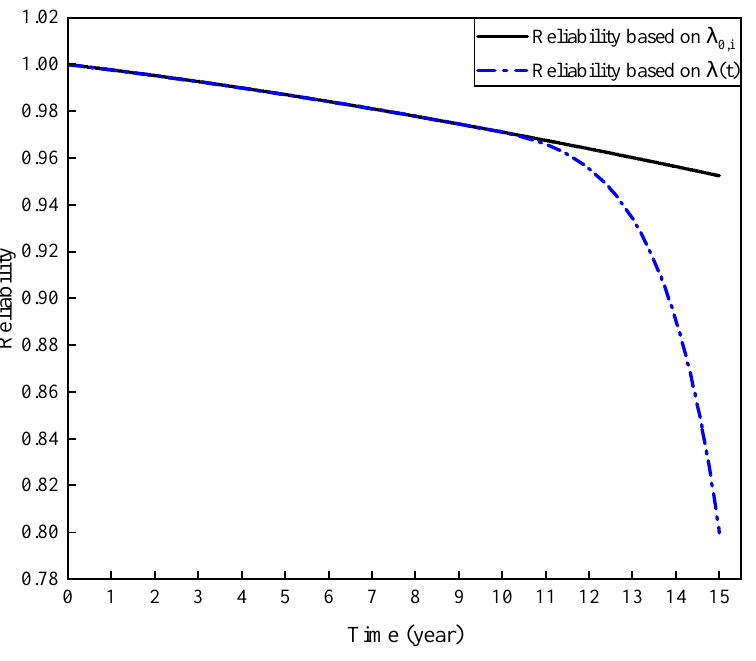
Figure 9. Reliability curves comparison diagram based on time-varying failure rate and constant failure